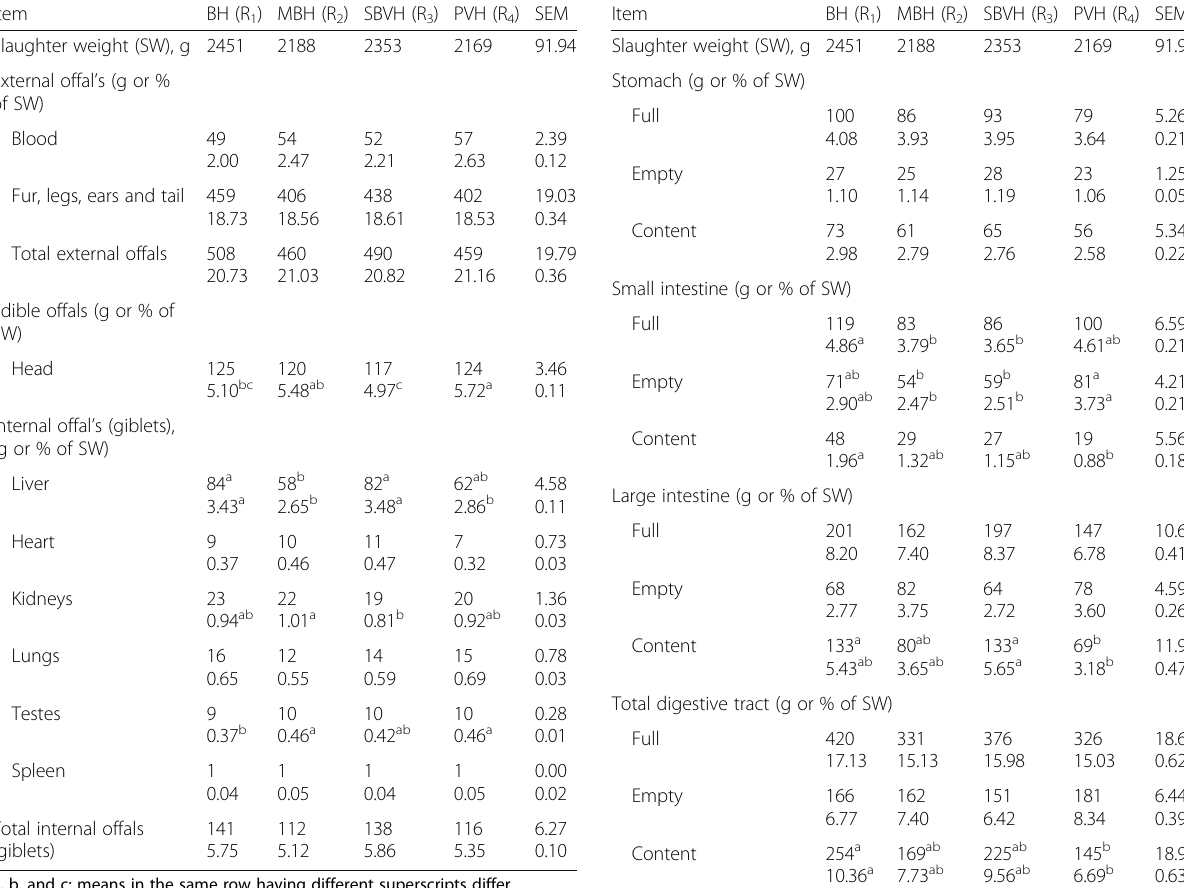
Table 7 Digestive tract weights and length of the experimental groups